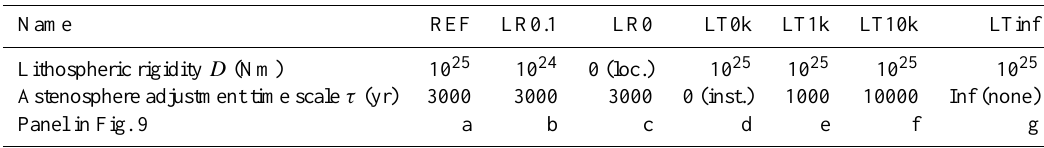
Fig. 8. Sensitivity of runoff partition between major oceanic basins to changes in DEM resolution. (a) 50km, (b) 25km, (c) 12.5km, (d) 6.25km. Table 1. Parameter settings for isostatic sensitivity